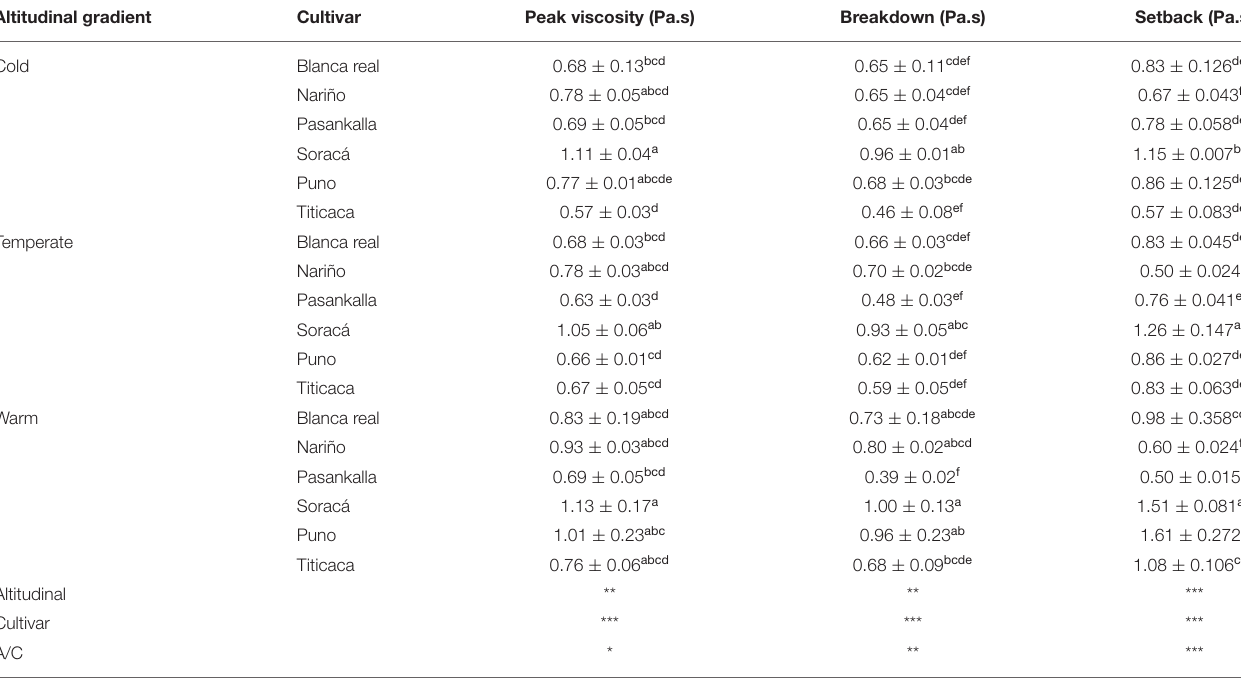
TABLE 5 | Pasturing parameters of different quinoa cultivars grown under three different altitudinal gradients. Altitudinal